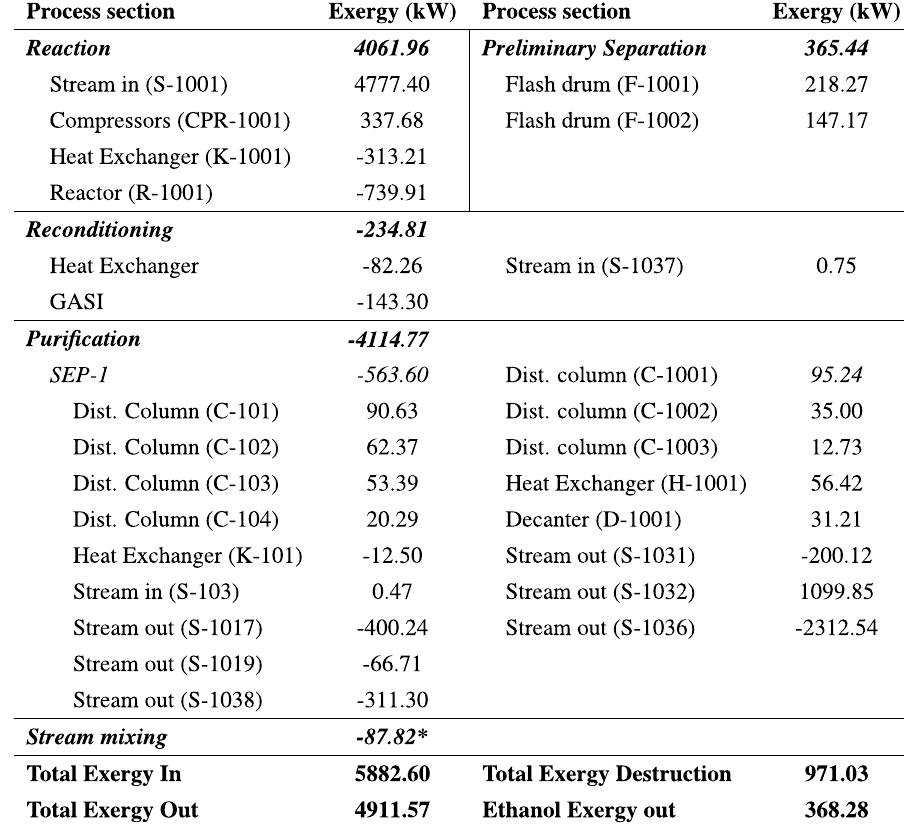
Table 4 Exergy quantification in each section of P-4